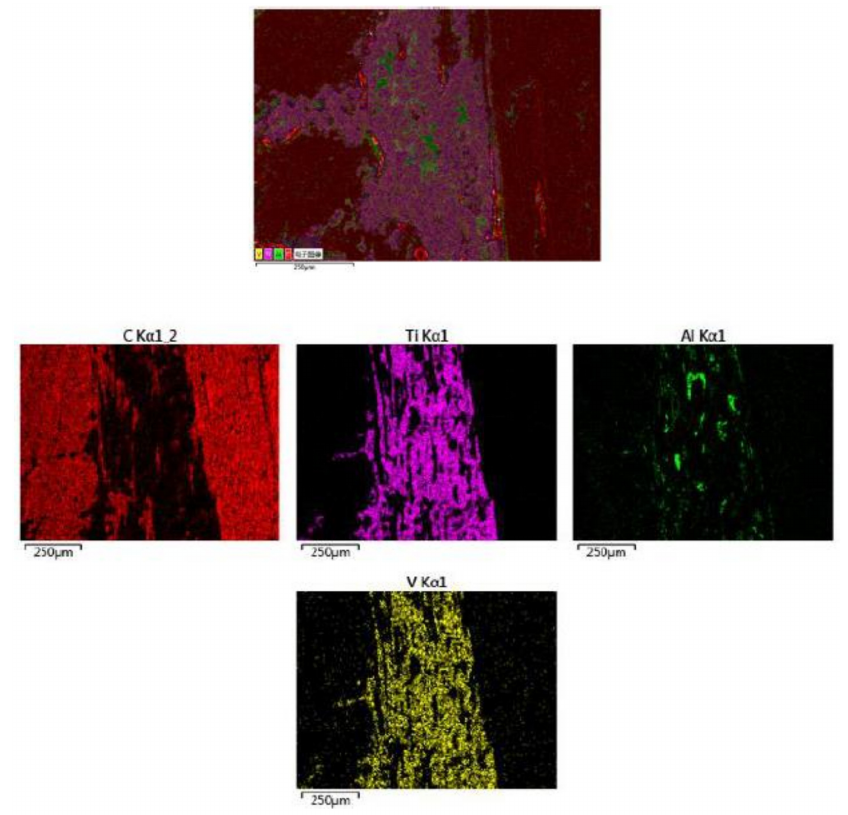
Figure 3. The EDS maps image of the Cf / C-TiC composite.